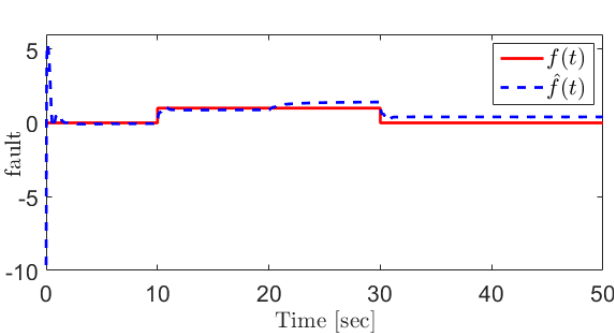
Figure 5. The EGR mass flow rate sensor fault and its reconstruction using SMO method [31].